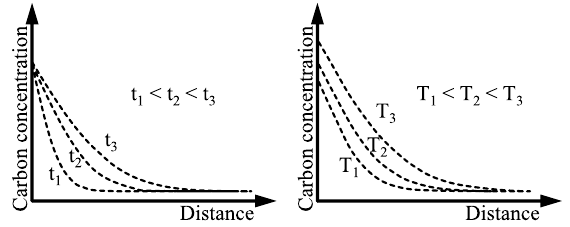
Fig. 12. Carbon pro fi le in dependency of carburization time and temperature according to Goldstein and Moren [23].